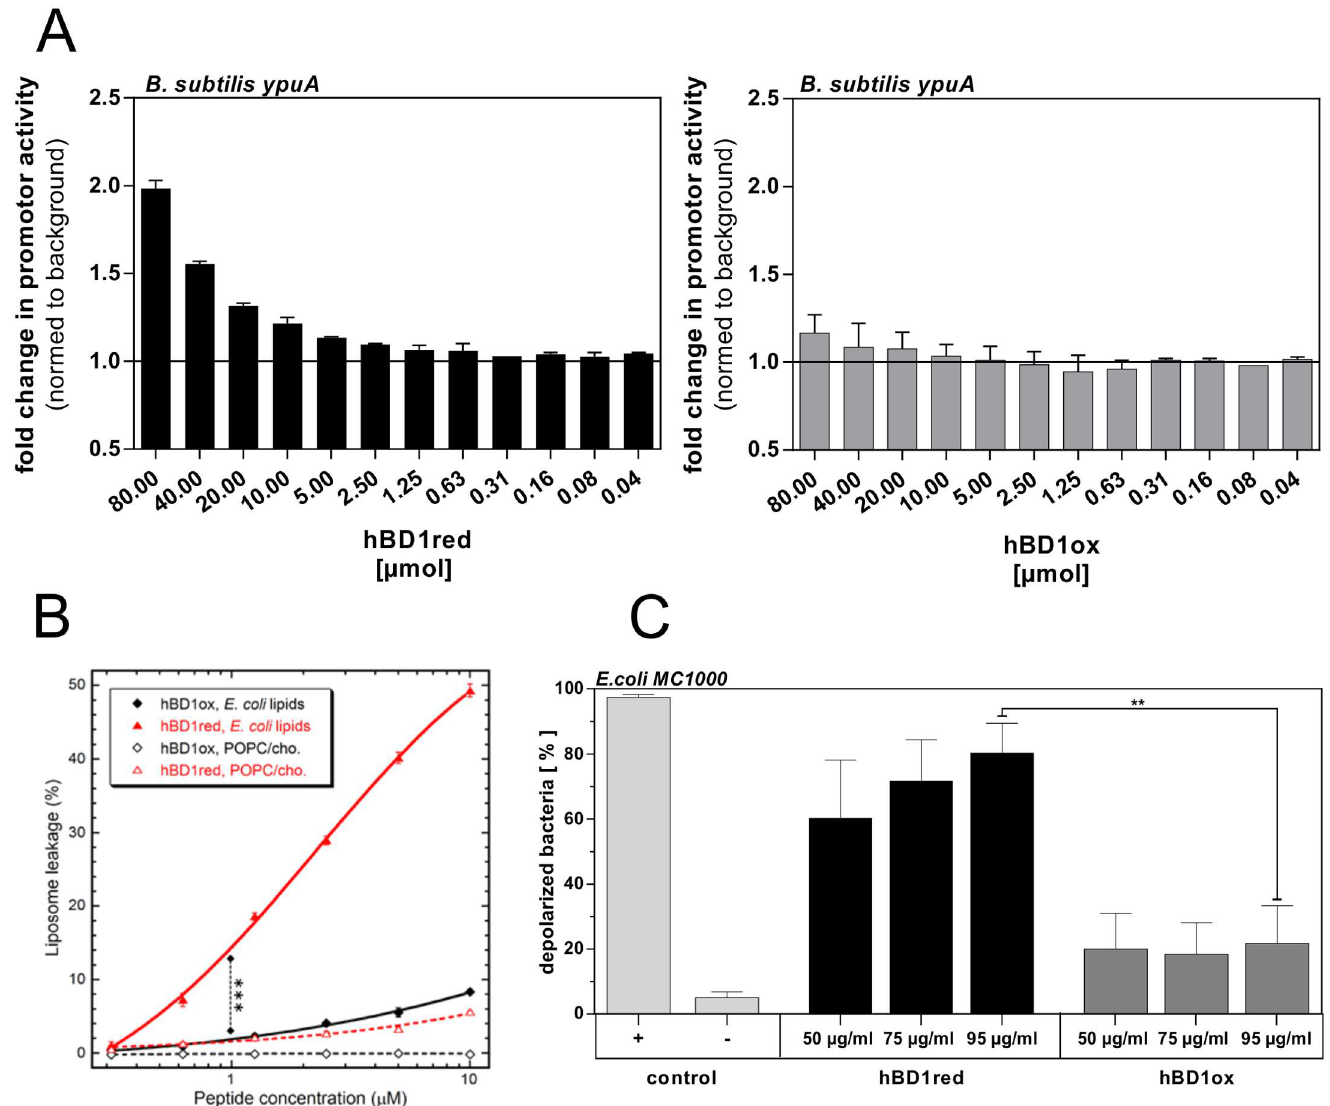
Fig 2. Characterization of the hBD1redtarget in bacterial compartments. (A) Transcription activity of the B . subtilis ypuA promoter indicativeof cell envelope damage.Bacteria were incubatedwith increasing concentrations of hBD1ox and hBD1red. (B) Membraneleakageas a result of hBD1 treatment was determined by quantifying carboxyfluoresceinefflux from liposomesPOPC/cholesterol(3:2 molar ratio, a human membranemodel)or an E . coli polar lipid extract. Presented is the leakagelevel reachedafter 45 min incubation with mean and standarddeviationsfrom triplicates. Permeabilization,by hBD1redon E . coli liposomes,was significantly higherthan by hBD1ox ( *** p < 0.001 only for 1 μ M). (C) Membranedepolarization of 1.5 x 10 6 CFU E . coli MC1000in responseto hBD1. 1 h treatment was analyzedby flow cytometry. Positive control (+) was incubatedwith hBD3ox (50 μ g/ ml) and the negativecontrol (-) without any peptide. The statistic was evaluatedby using student’s t-test with ** p = 0.0072. Data are presentedas mean +/- SEM of at least three independent experiments.